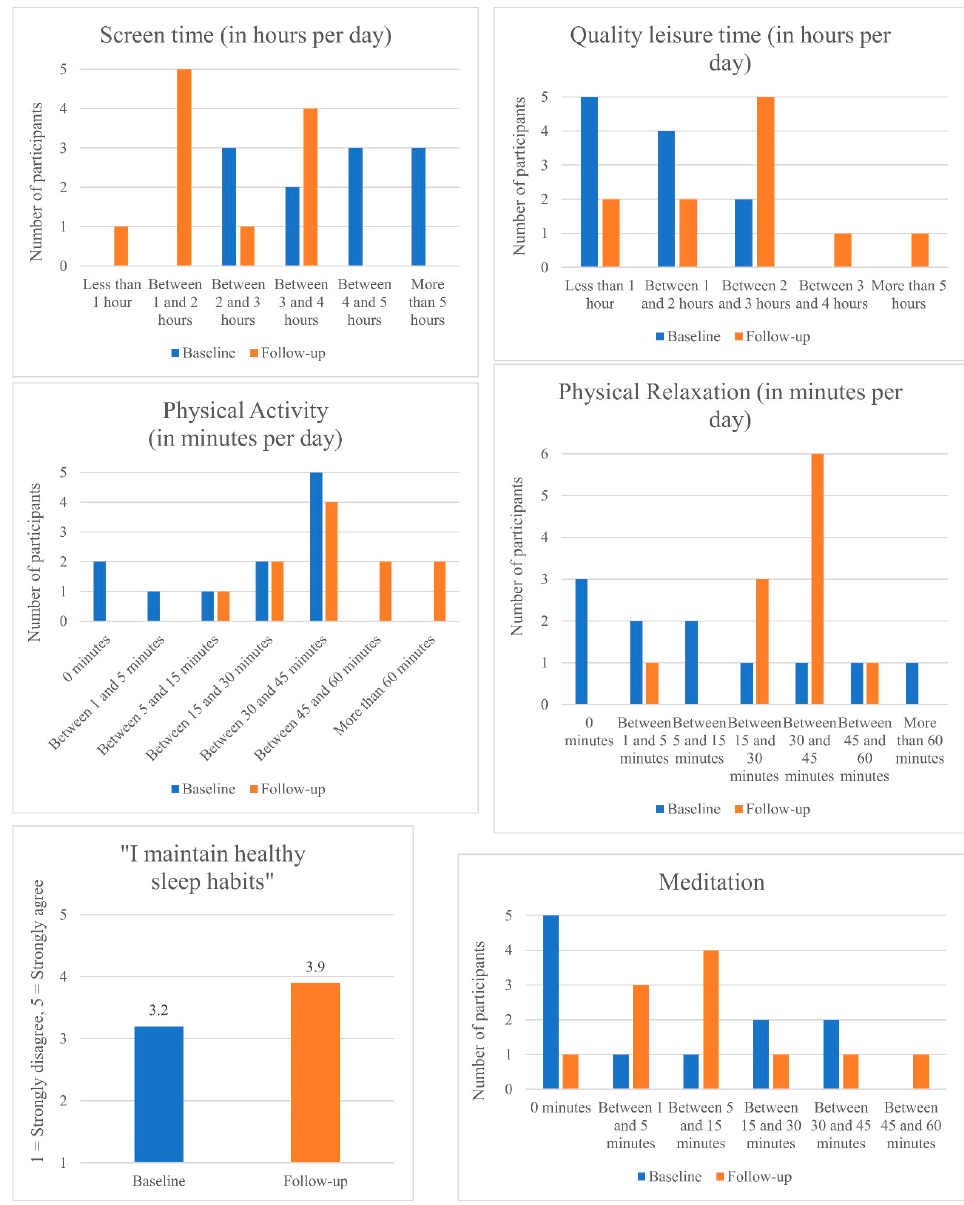
Figure 2. Changes in well-being behavior pre- and post-program.